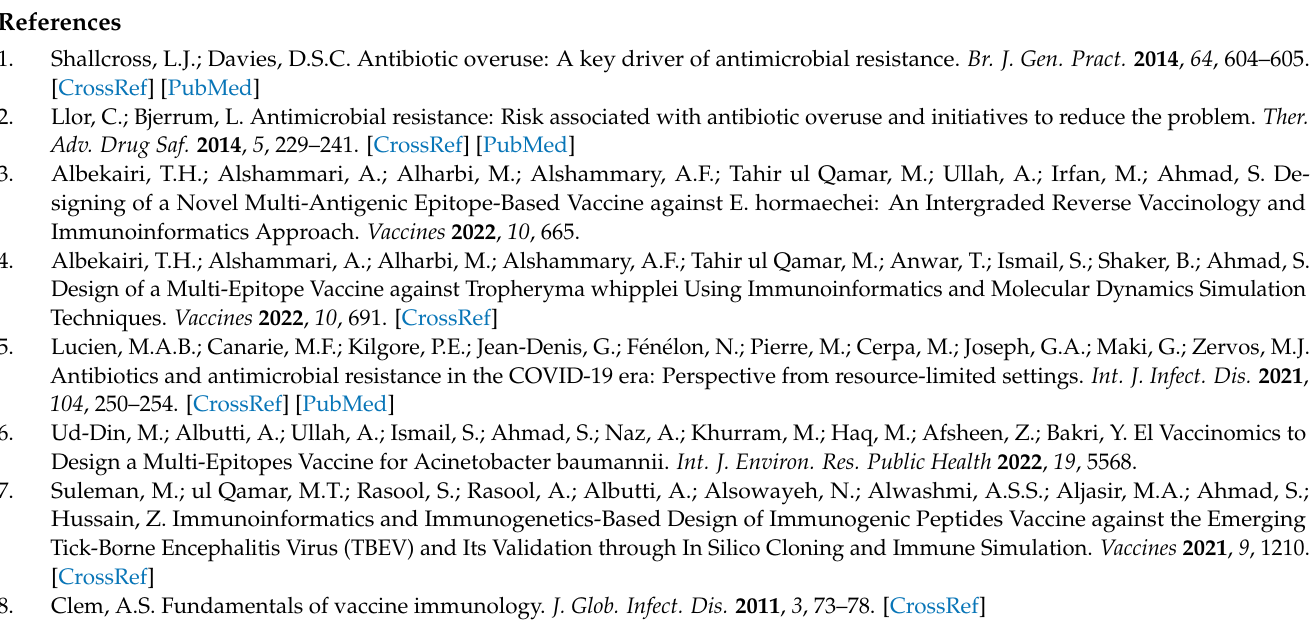
Table S6: Each term given is expressed in terms of energy in kJ.mol − 1 for FireDock solutions